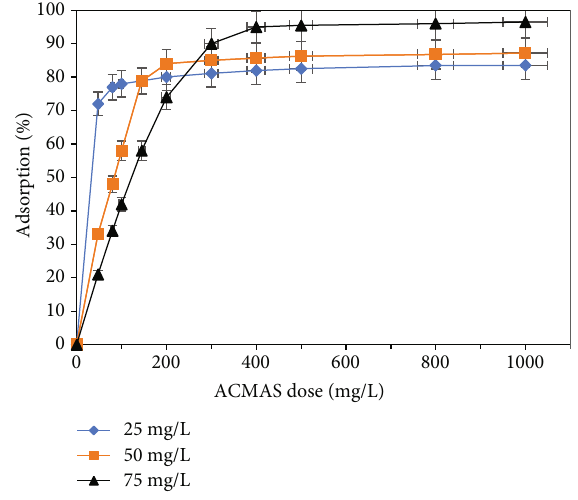
Figure 11: In fl uence of ACMAS dose for CV sorption ( time = 120 min , pH = 6 : 0